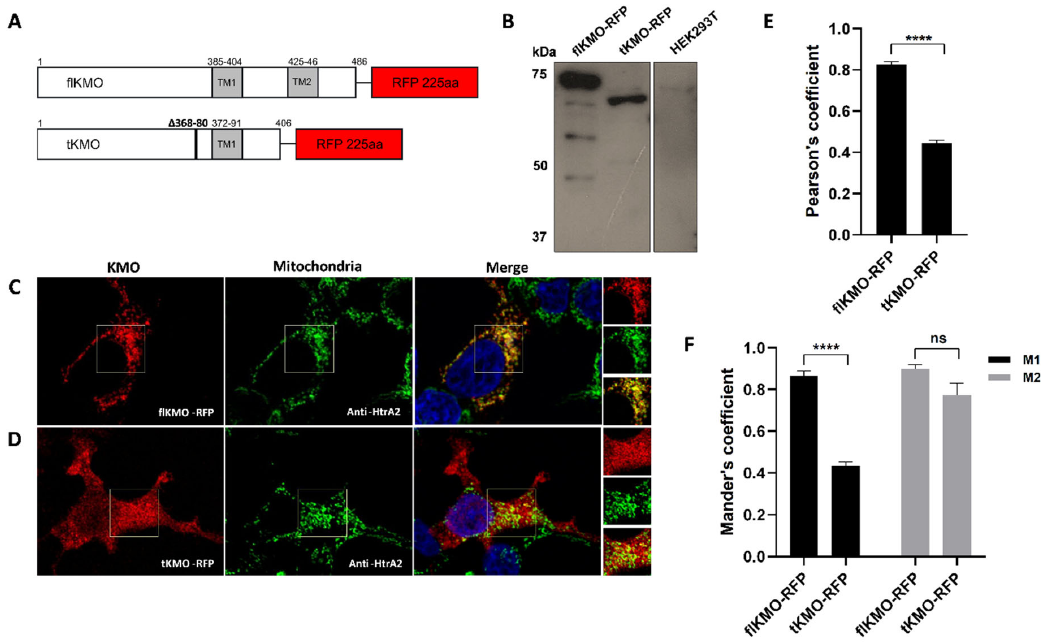
Figure 1. Exogenous KMO expression and localisation in HEK293T cells. ( A ) Schematic represen- tation of KMO ICC constructs: flKMO-RFP and tKMO-RFP. Grey boxes show putative transmembrane domains (TM). tKMO has a deletion of amino acids from position 368 to 380 that resembles the dele- tion in KMO isoform 2, but is also truncated at its C-terminus, with 67 aa missing from the